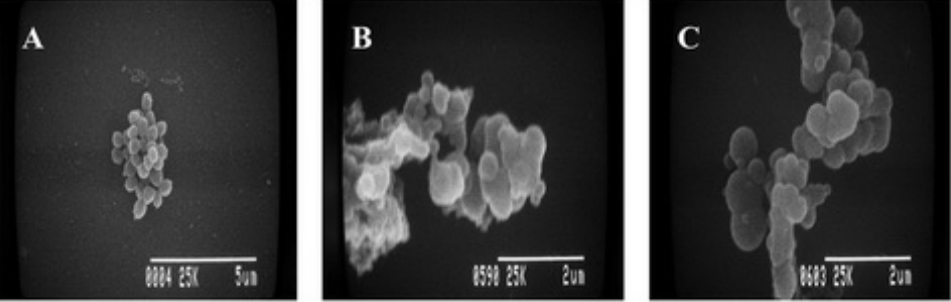
Figure 2. Scanning electron micrographs of S. aureus ATCC 25923 at 12 h after treatment with ( A ) 1% DMSO (control), ( B ) MSKE at 4 MICs and ( C ) PGG at 4